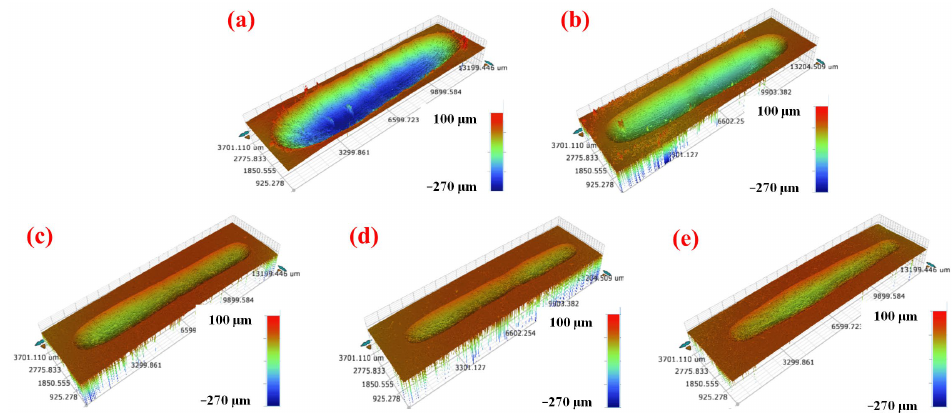
Figure 7. Three-dimensional morphologies of the worn surface of ( a ) neat PA 6, ( b ) PA 6/SEBS blend, ( c ) PA 6/SEBS/BF5, ( d ) PA 6/SEBS/BF10, and ( e ) PA 6/SEBS/BF20.